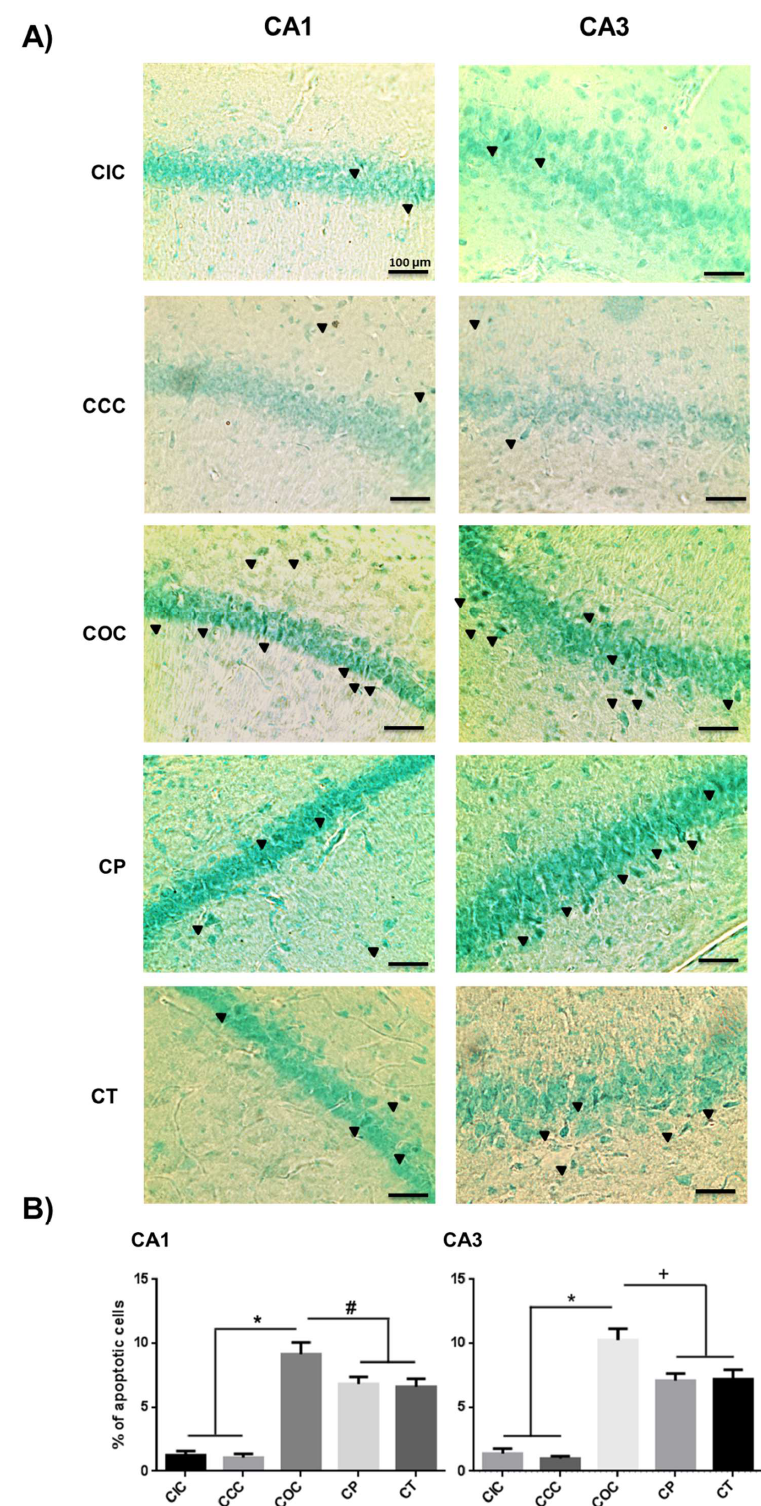
Figure 7. E ff ect of CUR on the quantitation of apoptotic hippocampal cells in the chronic phase. ( A ) Representative images of apoptotic cells (black arrows) in the CA1 and CA3 regions of rat hippocampus in the chronic phase are shown. The CP and CT groups presented a significantly decreased percentage of apoptotic cells than the COC group. Scale bars 100 µ m. ( B ) Total percentage of apoptotic cells are shown as mean ± SEM. SEM. * p < 0.001, + p < 0.01, # p <